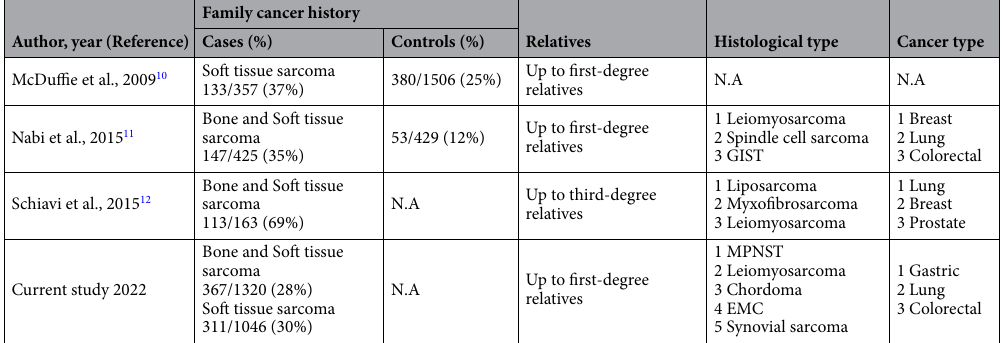
Table 7. Previous studies regarding family cancer history and histology of sarcoma and cancer type in sarcoma patients. GIST Gastrointestinal stromal tumor, MPNST Malignant peripheral nerve sheath tumor, EMC Extraskeletal myxoid chondrosarcoma, N.A. Not